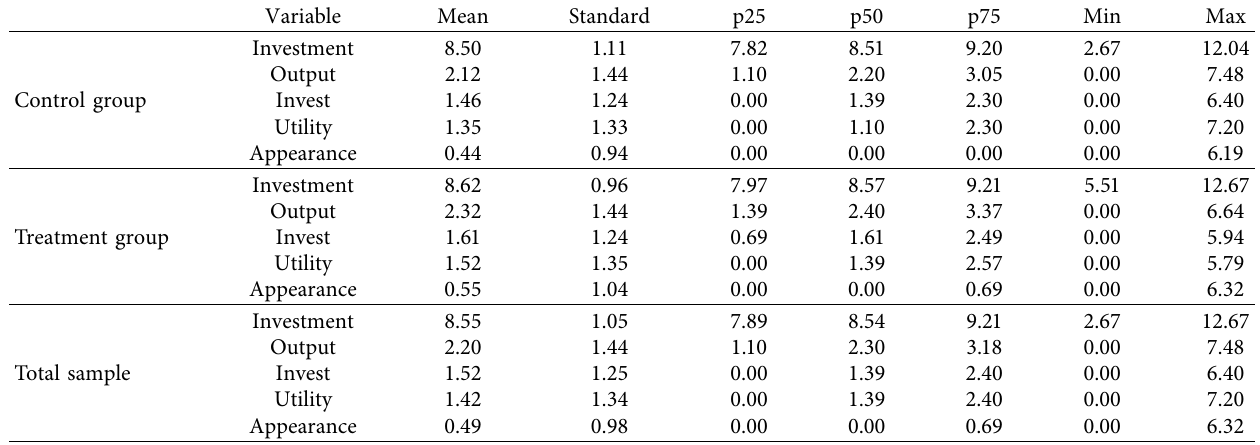
Table 4: Descriptive statistics of explained variables.